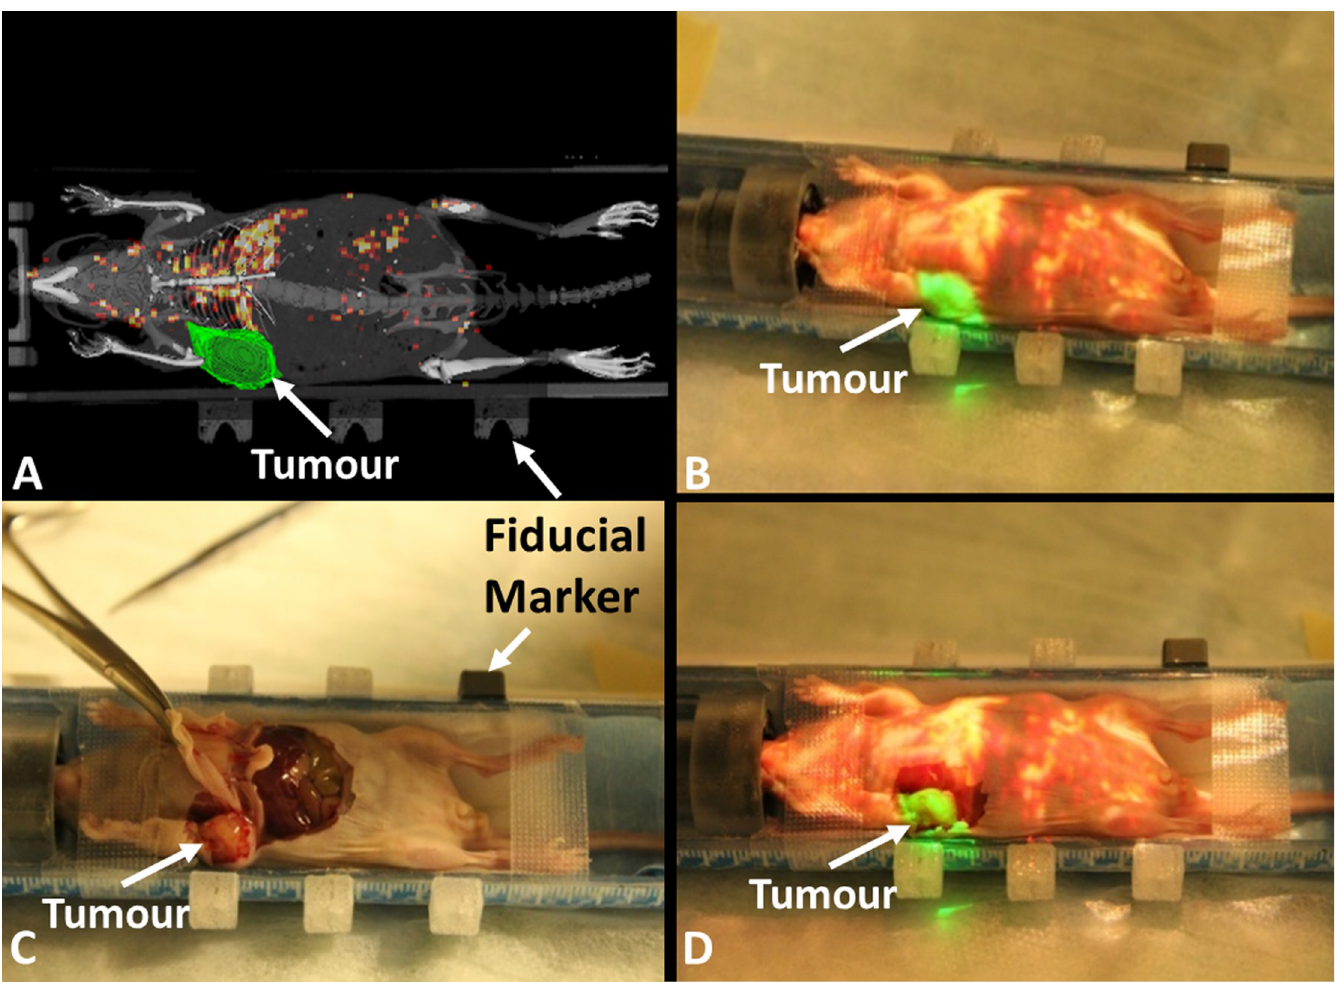
Fig 3. Augmented reality guided procedure with the breast carcinoma xenograft model. (A) projection image includes semi-opaque fused micro-CT and PET images with contour of tumor in green and skeleton of mouse in gray. (B) projection image overlaid on top of the mouse indicates the tumor location (green) and highlights isotope uptake in the liver. (C) mouse dissection demonstrating the tumor location. (D) mouse dissection with the overlaid projection image demonstrating the correct anatomical localization of the virtual contoured tumor on the mammary fat pad tumour.